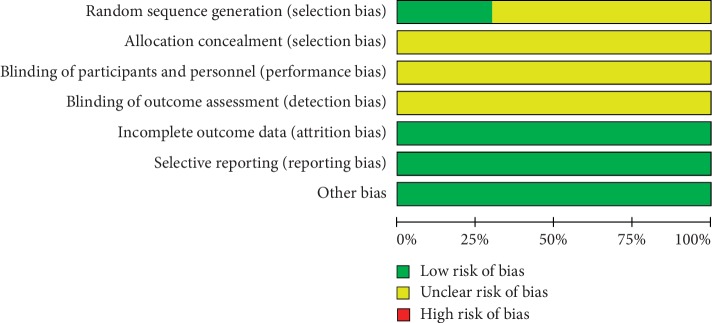
Risk of bias graph.